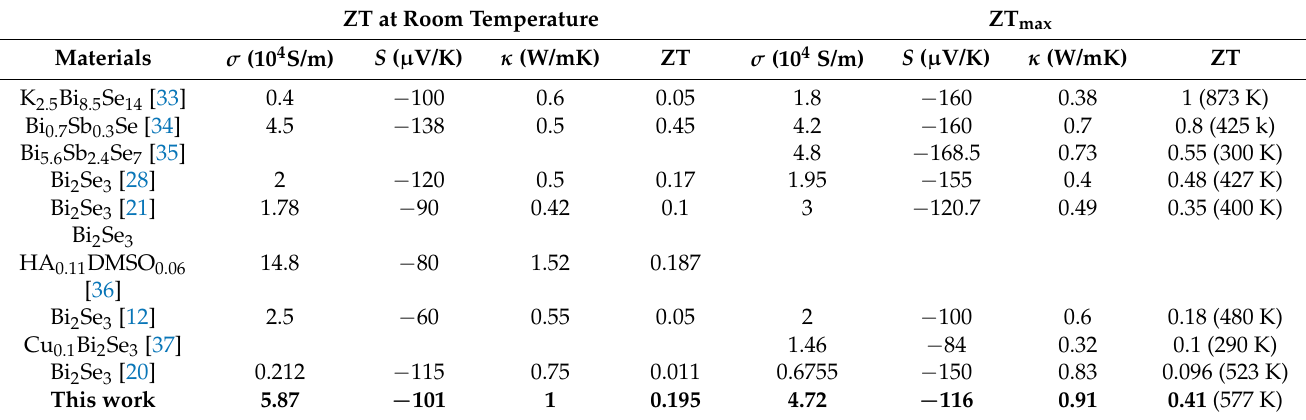
Table 2. A comprehensive summary of the thermoelectric performance of the previously reported Bi 2 Se 3 . ZT at Room Temperature ZT max